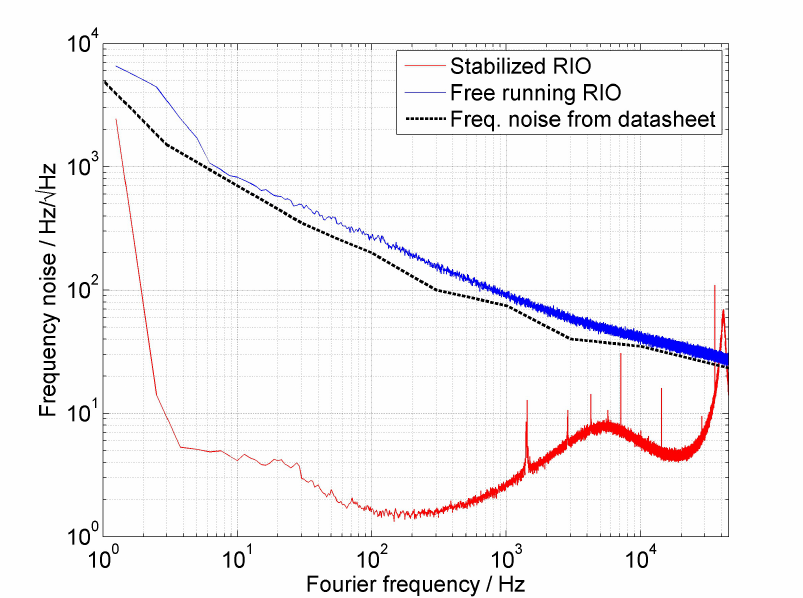
Figure 2. Single sideband frequency noise analysis of the ORION laser module.